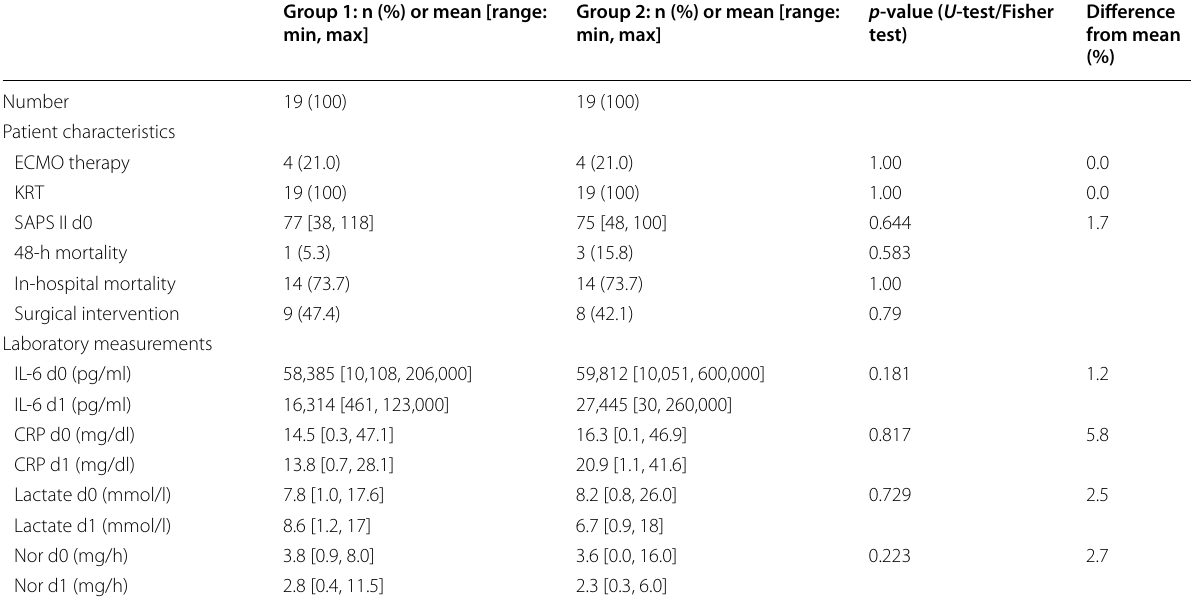
Table 2 Patient characteristics and laboratory measurements after PS matching analysis